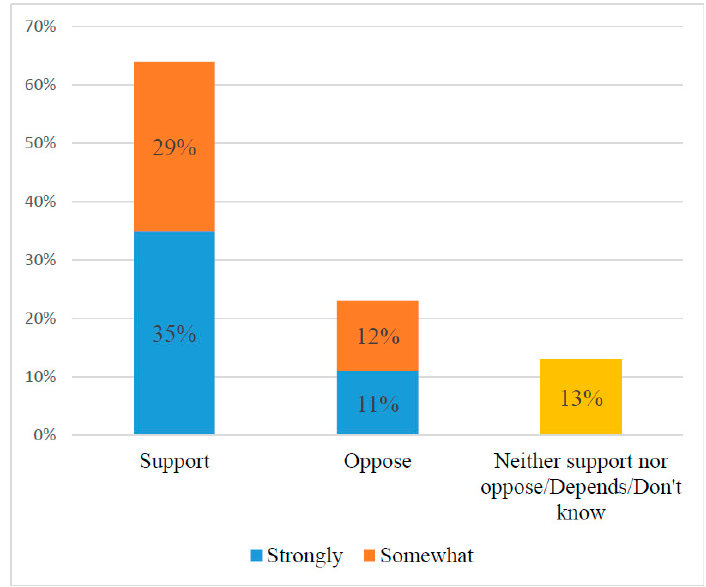
Figure 3. Willingness to pay more taxes or user fees for higher health spending: Source: Author’s